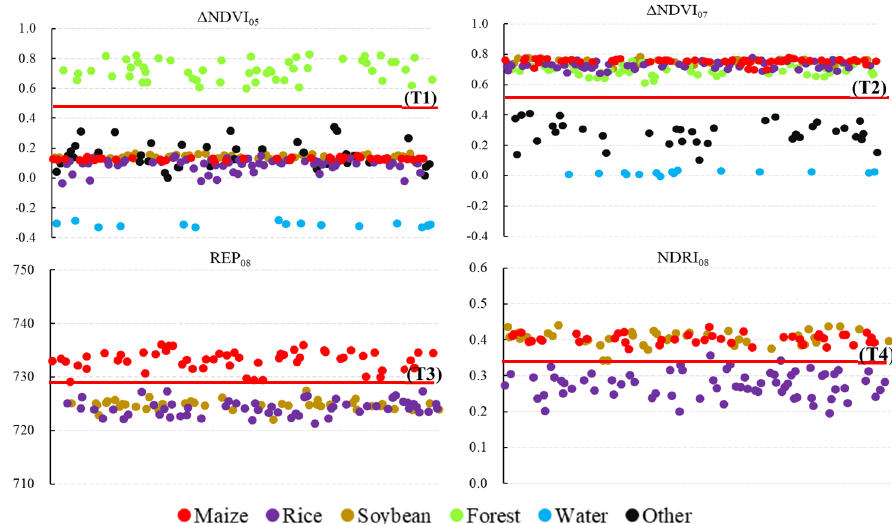
Figure 4. Comparison between the temporal profiles of the normalized difference vegetation (NDVI), red-edge parameter (REP), and normalized difference rice index (NDRI) for the different land cover types on the Northeast Plain. Red lines represent the classification threshold.